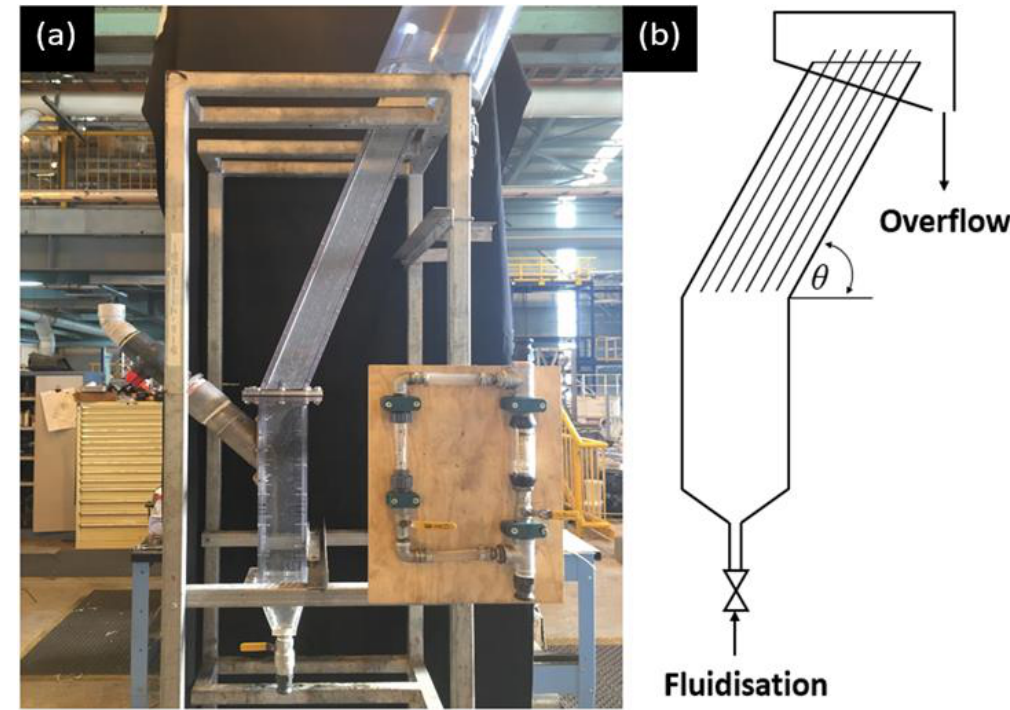
Figure 1. ( a ) Photograph of the RC80 REFLUX TM Classifier used for particle fractionation experiments and ( b ) schematic diagram of a semi-batch REFLUX TM Classifier with fluidisation supplied through the underflow value.